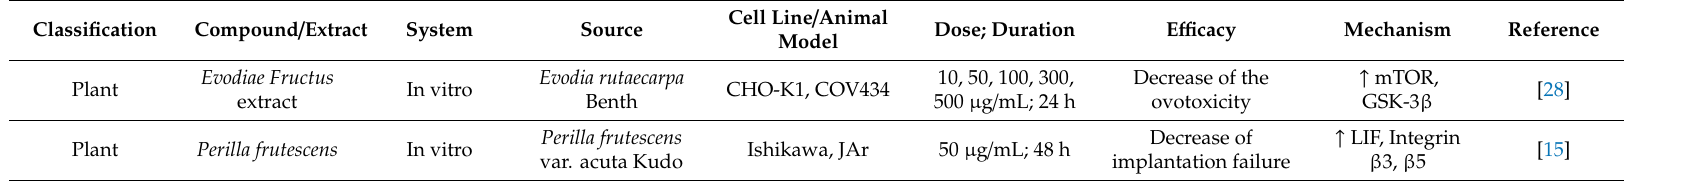
Table 7. Plant derived natural products and female infertility (in vitro